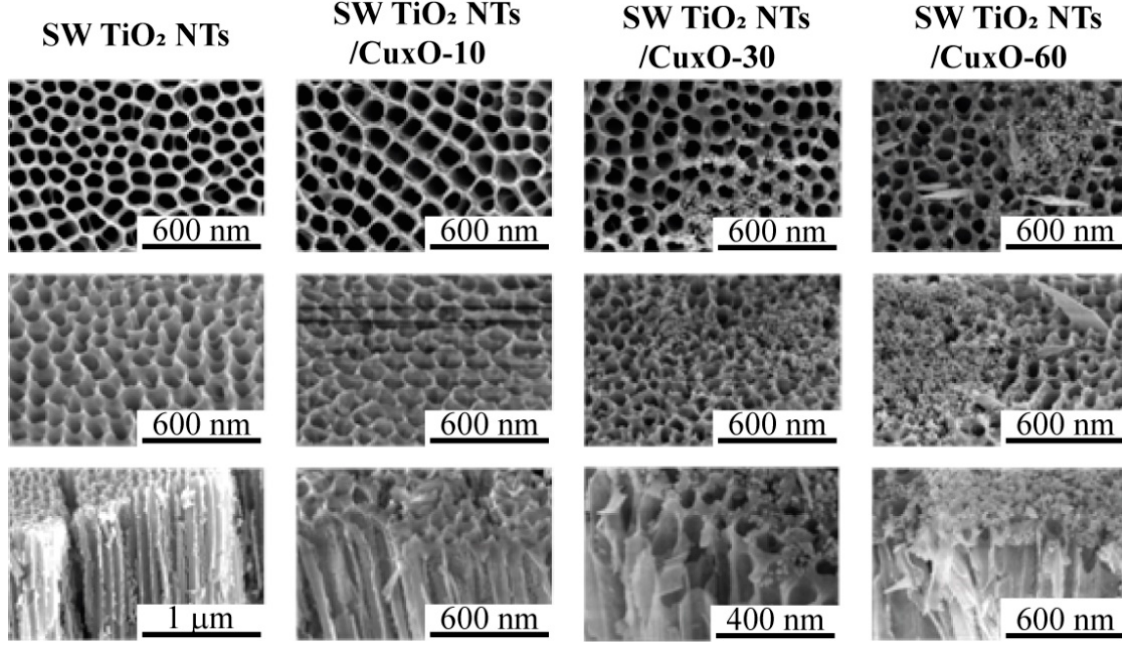
Figure 1. SEM images of SW TiO 2 NTs array surface before and after copper oxide Cu x O deposition.